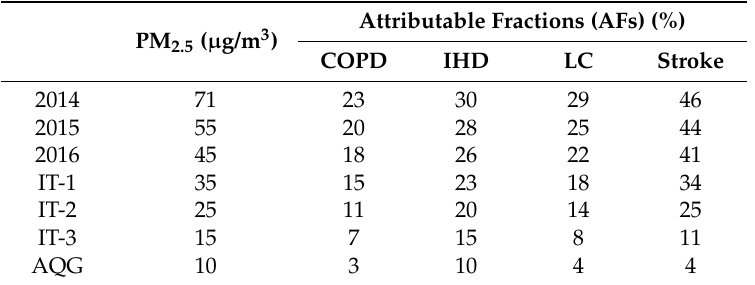
Table 2. The attributable fractions due to PM 2.5 for chronic obstructive pulmonary disease (COPD), ischemic heart disease (IHD), lung cancer (LC) and stroke under target scenarios.